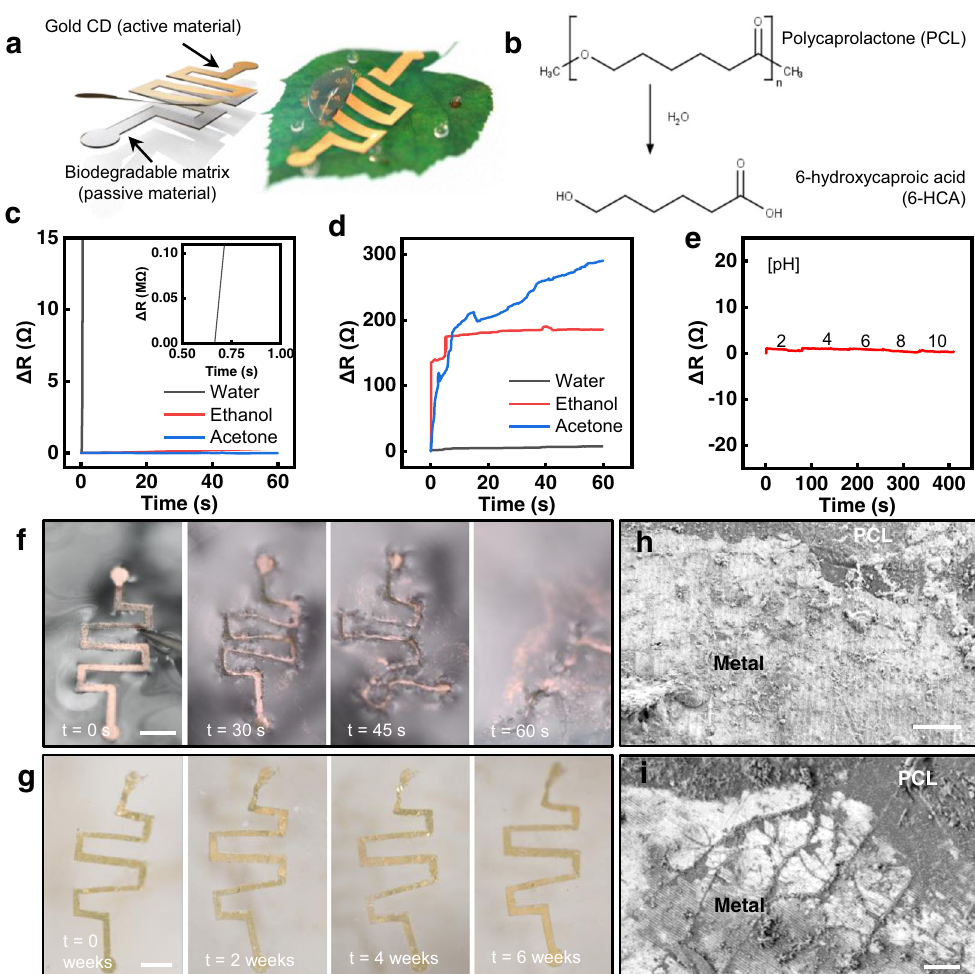
Fig. 5 Moisture-triggered performance of the UCDEs as a biodegradable resistor. a Schematic design, enabling biodegradable electronics for fully recyclable devices. b Chemical reaction responsible for triggering transience. c PVA-based, electrical degradation performance in various solvents. d PCL- based, electrical degradation in various solvents and e stability in different pH solutions. Degradation vs. time images in PBS (pH 7.4) of the f PVA and (scale bar, 3 mm) g PCL-based resistor (scale bar, 3 mm). SEM of metal-PCL interface: h before degradation and i after 6 weeks soaked in PBS (7.4 pH) at 37 °C (scale bar 10 µ